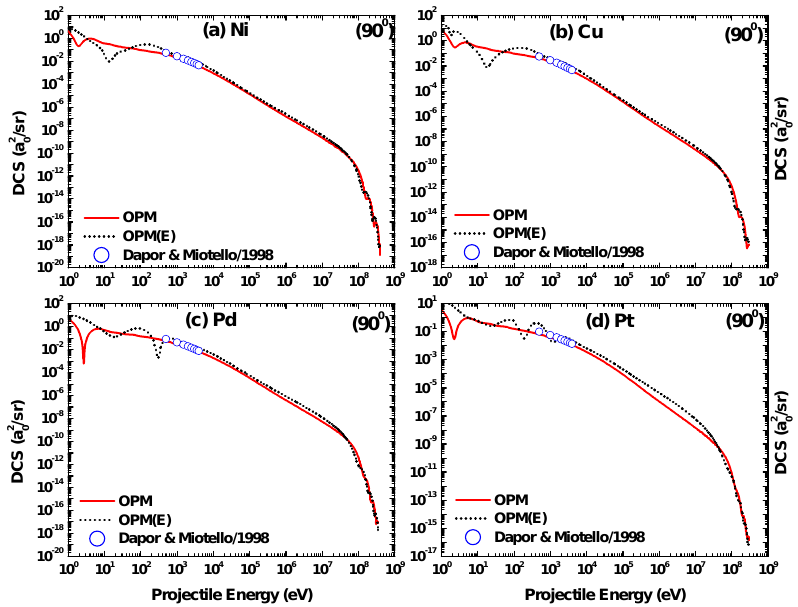
Figure 24. Energy dependent differential cross-sections for positron (—–) scattering from ( a ) Ni 58 , ( b ) Cu 63 , ( c ) Pd 108 , and ( d ) Pt 196 at a scattering angle θ = 90 ◦ . The calculations of Dapor and Miotello [50] are shown as well. The electron scattering results ( · · · · · · ) from Figure 16 are included for